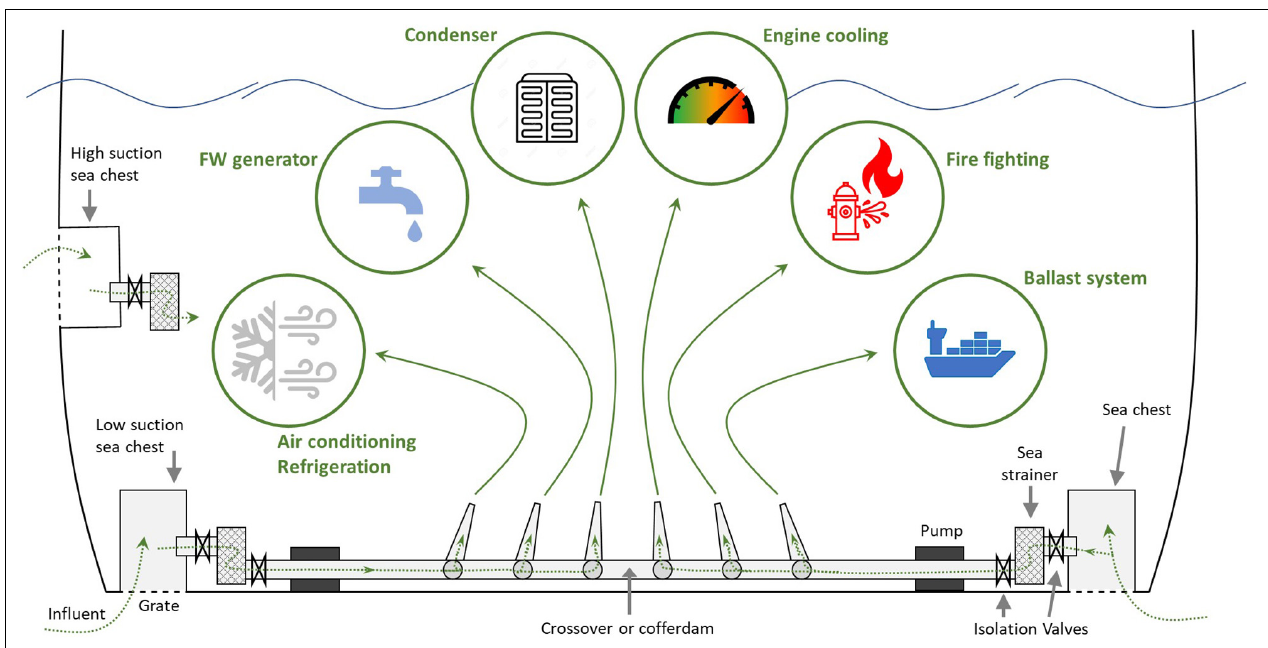
FIGURE 1 | Schematic of initial sea water passage through an integrated ISS, depicting the range of uses for sea water on board a ship. Diagram based on Coutts and Dodgshun (2007); Kongsberg (2014); and Gust et al. (2018b). FW refers to fresh